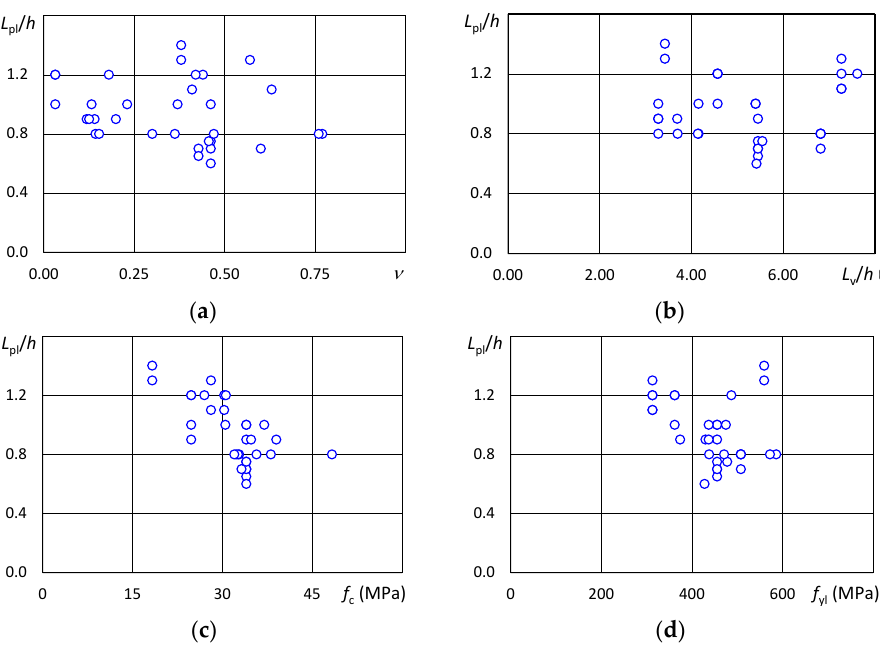
Figure 8. Normalized length of the plastic hinge versus ( a ) normalized axial force, ( b ) shear span ratio, ( c ) compressive strength of concrete, and ( d ) yield strength of longitudinal rebars.